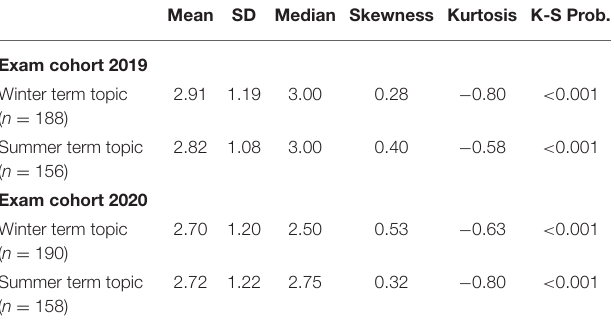
TABLE 1 | Distribution of separate grades per topic from the exam cohorts 2019 and 2020, grouped according to the term in which the topic had been taught (summer vs. winter term).